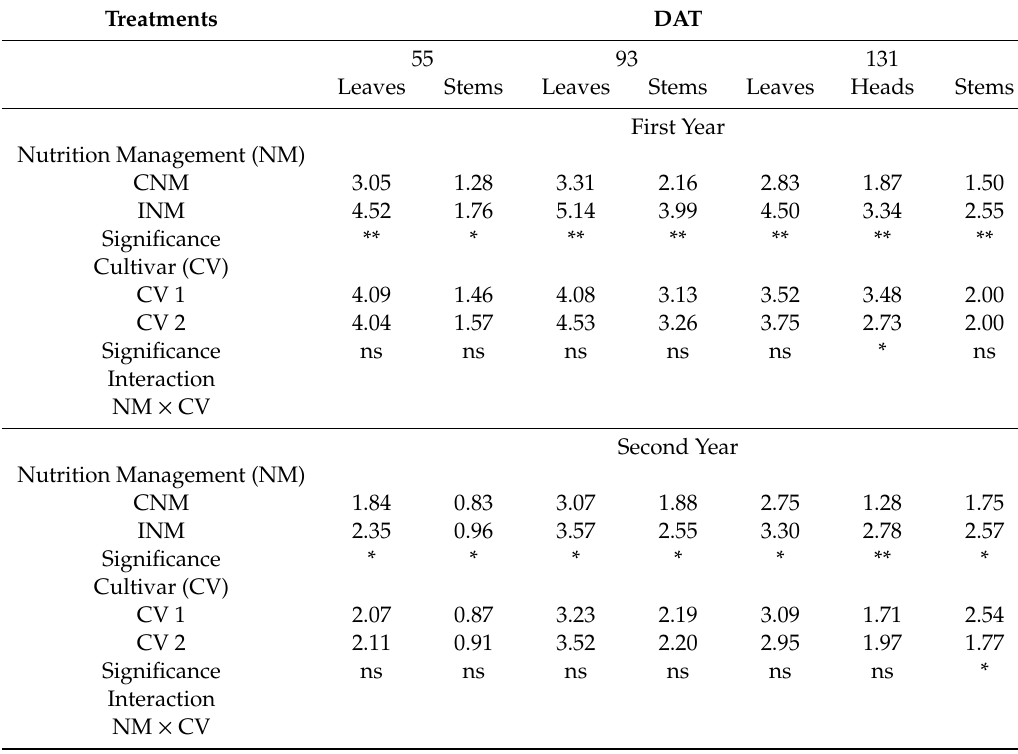
Table 7. Main e ff ects of nutrient management and cultivar on N accumulation (g m 2 ) in di ff erent organs at three di ff erent DAT in chrysanthemum plants over the two years of